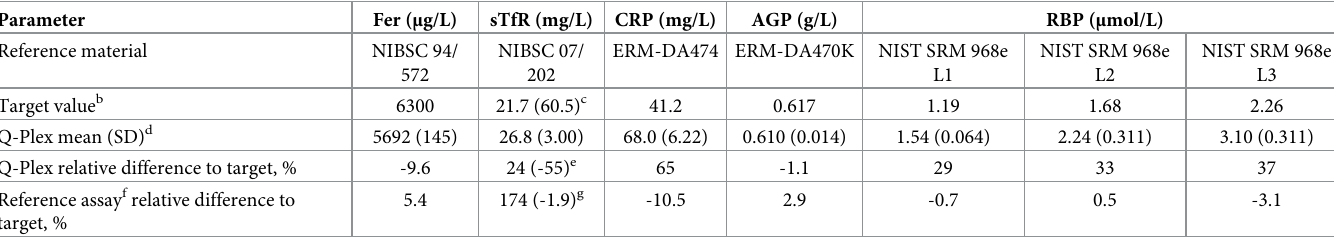
Table 4. Q-Plex and reference assay performance with international reference materials a